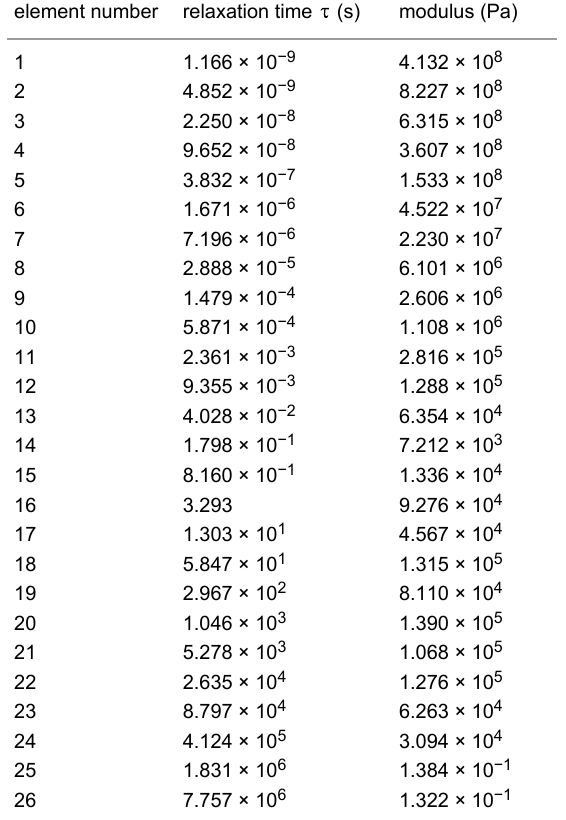
Table 1: Generalized Maxwell parameters for poly-isobutylene given by Brinson and Brinson [17]. element number relaxation time